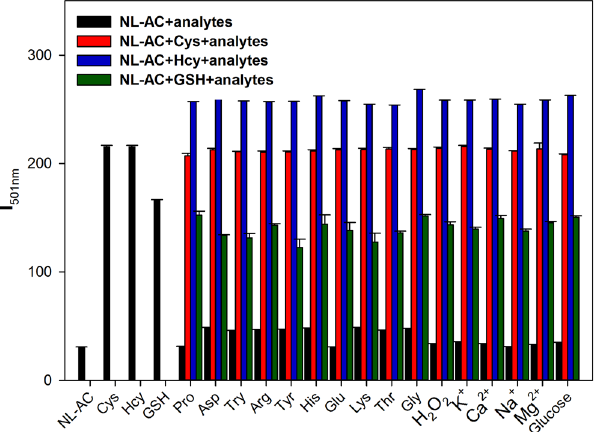
Figure 6. Fluorescence intensity (I 501nm ) of NL-AC (10 μ M) without or with biothiols (200 μ M) in the presence of various analytes (200 μ M) in HEPES buffer solution (DMSO/HEPES = 8:2, pH 7.4, λ ex = 336 nm, slit: 5.0 nm/5.0 nm).